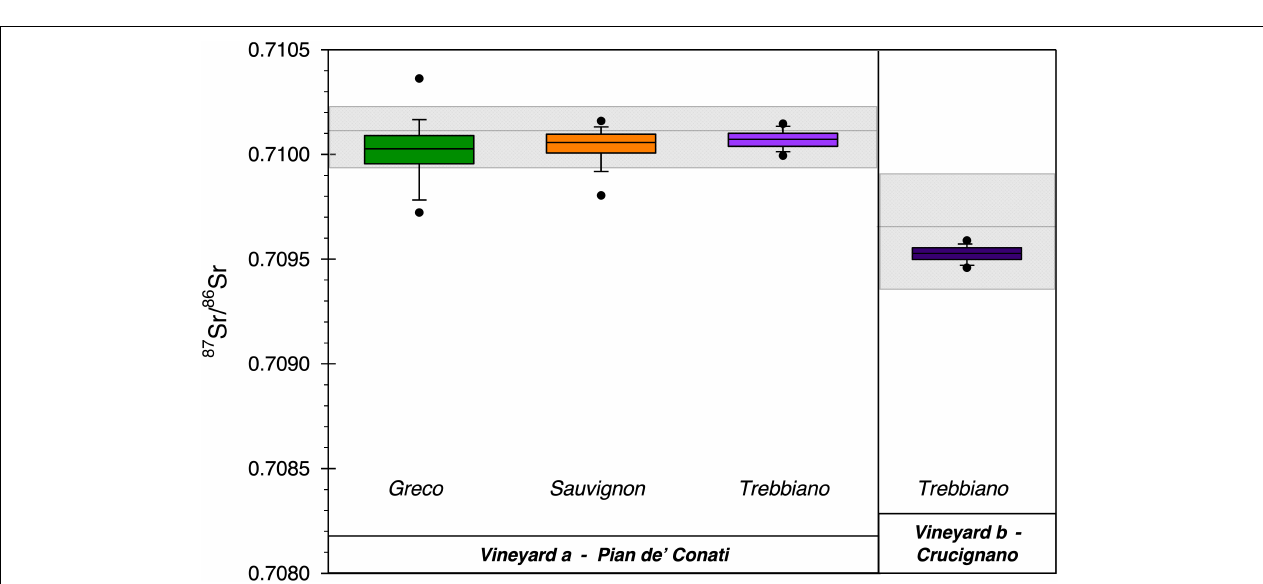
FIGURE 2 | 87 Sr/ 86 Sr values in the wine samples from different vintage years. Both multiple-variety ( Numero Sei and Isolina ) and varietal ( Greco and Tufo Bianco ) wines are reported. The box is delimited by the 25th and the 75th percentiles of each population, the whiskers show the 10th and the 90th percentiles, whilst the dots represent the outliers at the 5th and 95th percentiles. The yellow fields represent the variability range (at the 5th and 95th percentiles) of the grapes grown in the two respective areas of Pian de’ Conati (vineyard a ) and Crucignano (vineyard b ).